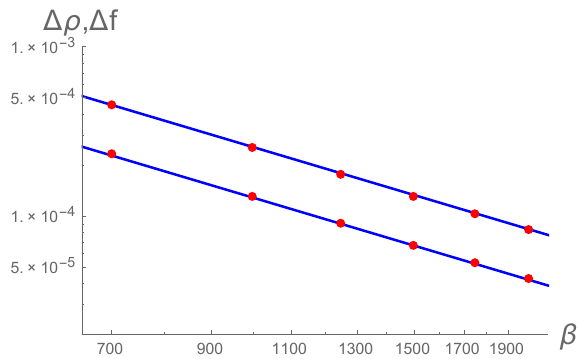
Figure 22 . (cid:1) (cid:26) (upper curve) and (cid:1) f (lower curve) vs (cid:12) for the boson star building processes described in the main text. The blue lines correspond to the (cid:12)ts (cid:1) (cid:26) , (cid:1) f (cid:24) (cid:12) (cid:0) 1 : 6079 . (cid:12)ve signi(cid:12)cant digits. On the other hand, the frequency of this boson star is ! ! = 2 : 9. The simulated solution and the actual boson star the system equilibrates to are f compared in (cid:12)gure 21b. In this case, after the quench both (cid:1) (cid:26) and (cid:1) f are compatible with the numerical